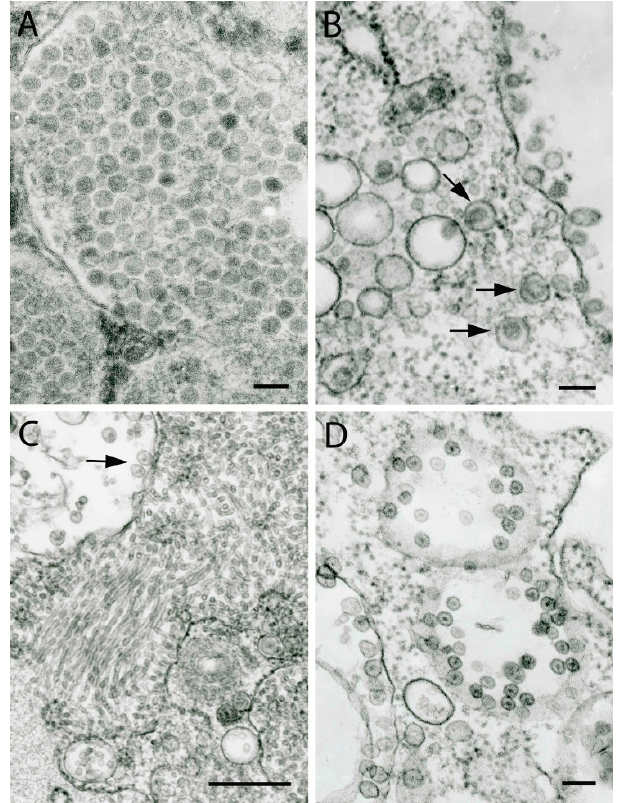
Figure 8. Ultrastructure of probable mesoniviruses and negeviruses. ( A ) Fragments of three large vacuoles in the cytoplasm of a C6/36 cell with virions 55 nm in diameter of Cavally virus (unclassified; probable genus Alphamesonivirus , family Mesoniviridae , order Nidovirales ). Bar = 100 nm. ( B ) Virions (45-55 nm in diameter) of Bontag Baru virus (strain JKT-9891; unclassified, probable genus Alphamesonivirus , family Mesoniviridae , order Nidovirales ), inside small cytoplasmic vacuoles (arrows) and at the surface of a C6/36 cell. Bar = 100 nm. ( C ) Fragment of a C6/36 cell infected with Negev virus (strain Houston-M30957-58; unclassified, proposed genus Negevirus ), with enormous expansion of perinuclear space filled with tubules ~15 nm in diameter and of different lengths (up to 250 nm). The arrow indicates spherule-like structures ~65 nm in diameter in a vacuole at its periphery. Bar = 0.5 μ m. ( D ) Three vacuoles with spherule-like structures 45 nm to 55 nm in diameter at inner periphery of their membranes in a C6/36 cell infected with Santana virus (strain BeAr 517449; unclassified; proposed genus Negevirus ). Bar = 100 nm.